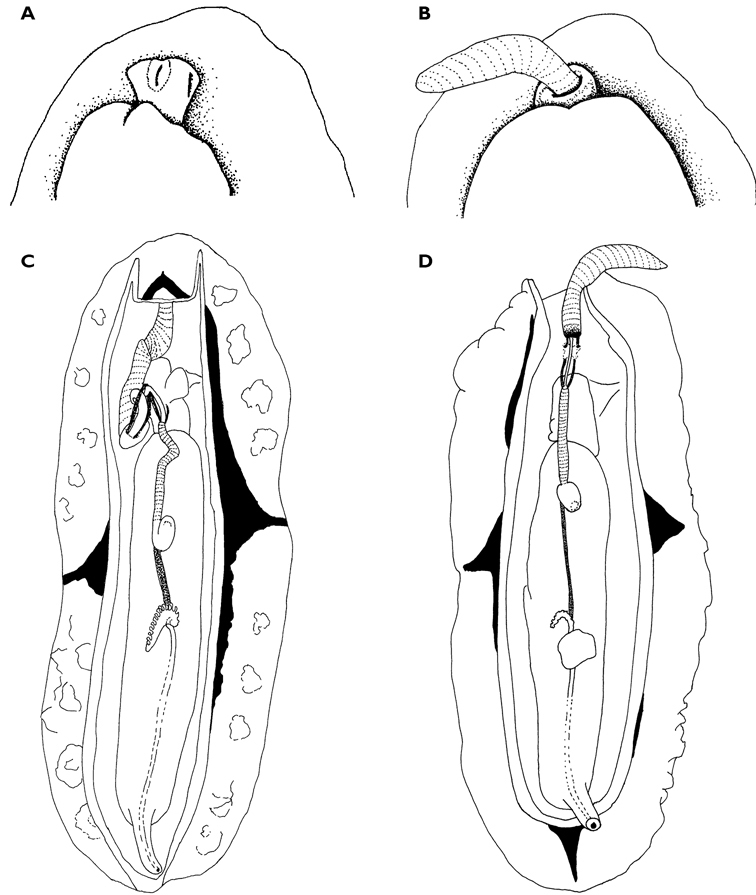
Phyllidiopsis shireenae
A ventral view of 80 mm specimen B ventral view of 95 mm specimen with mouthparts extruded C digestive anatomy of 75 mm specimen D digestive anatomy of 95 mm specimen.